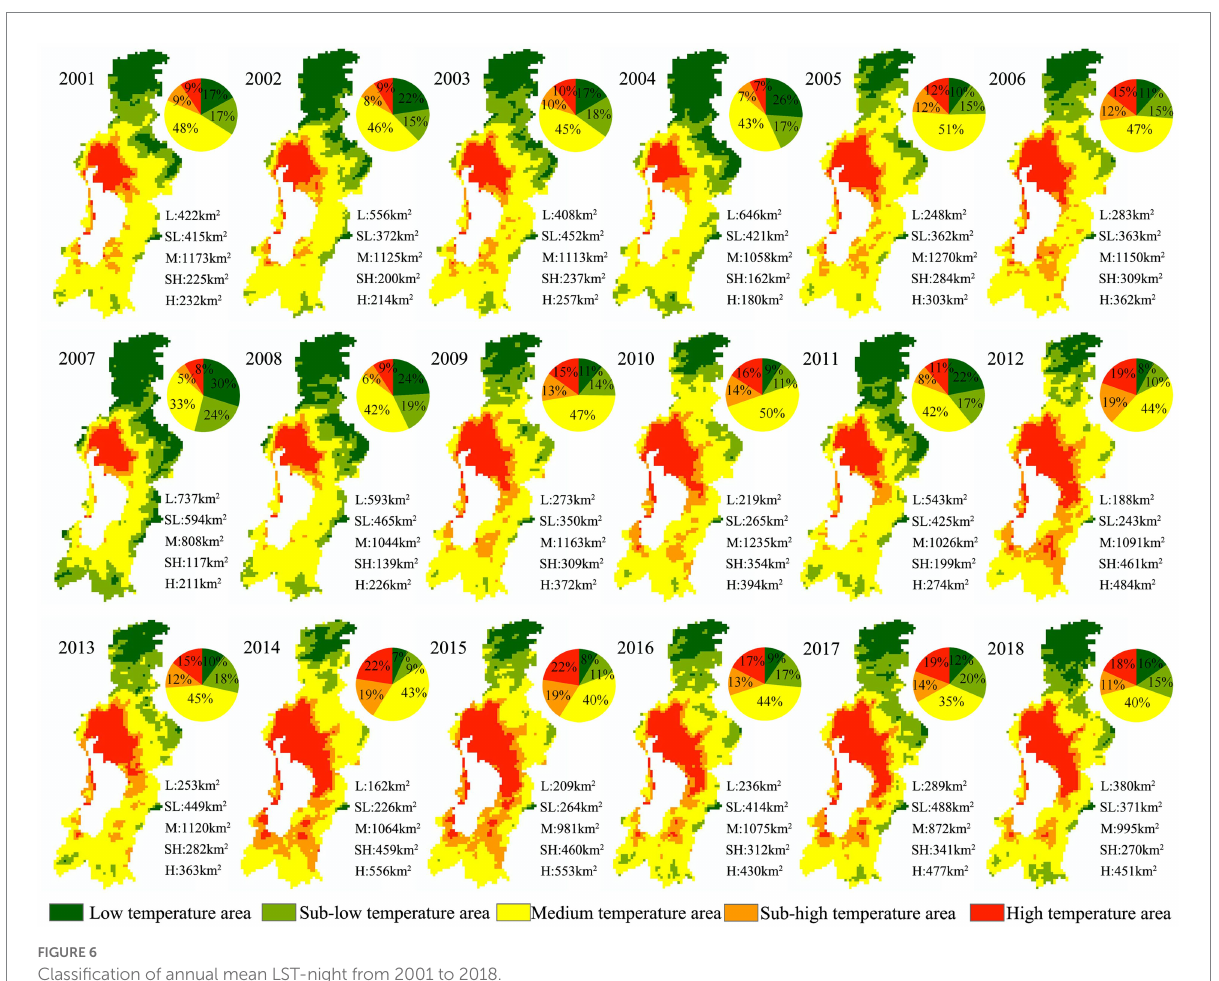
FIGURE 6 Classification of annual mean LST-night from 2001 to